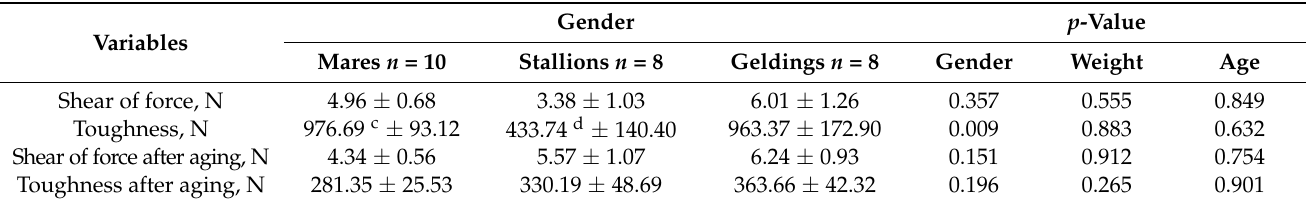
Table 4. Effects of horse gender, age, and carcass weight on Warner–Bratzler shear force parameters in cooked pectoralis profundus muscle, before and after